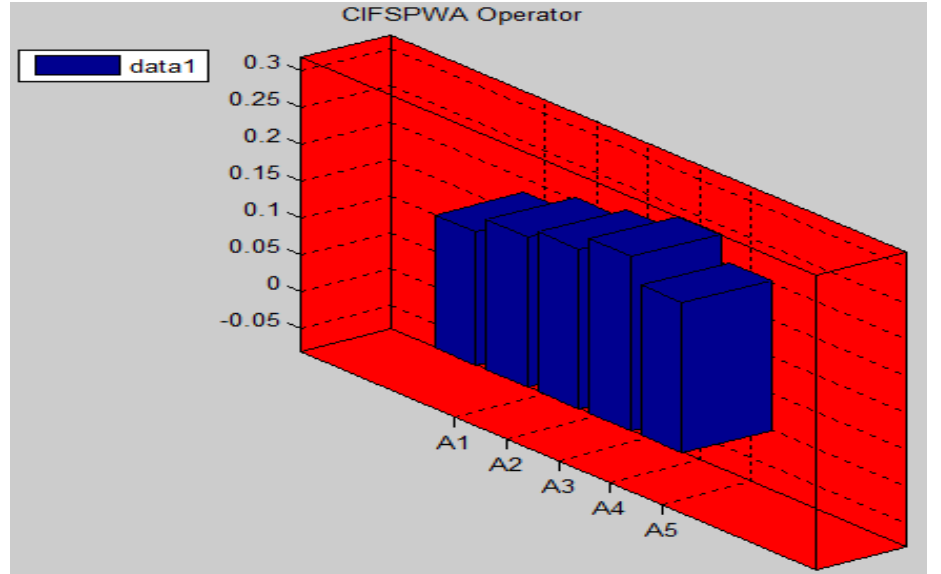
Figure 3. Graphical expressions of the information in Table 11.